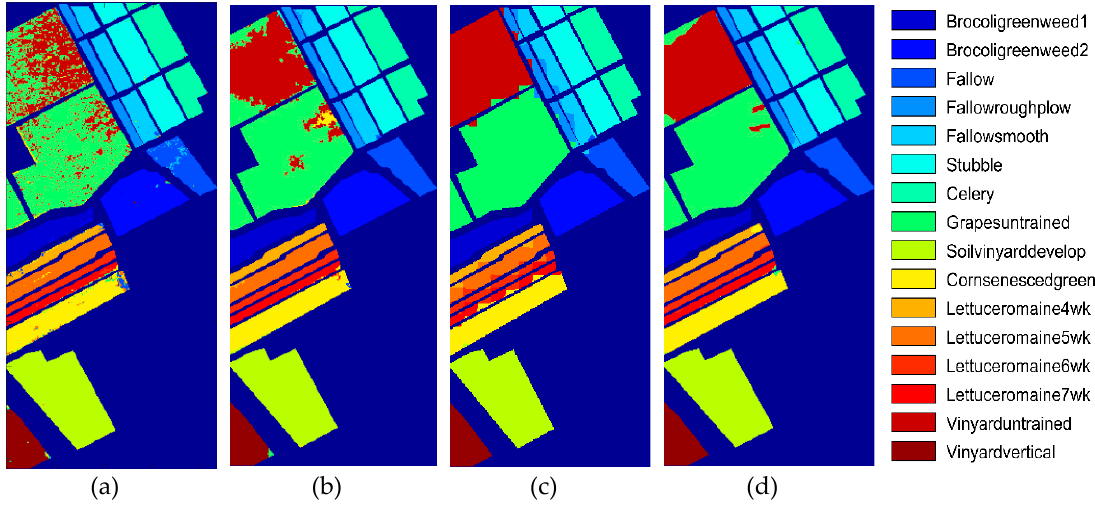
Figure 8. The classification results of Salinas dataset. ( a ) SVM. ( b ) SVM-SP ( s = 15). ( c ) DPR-SVM-POS (m = 15, s = 15 and β = 0.9). ( d ) DPR-SVM-SP ( s = 15 and β = 0.9).